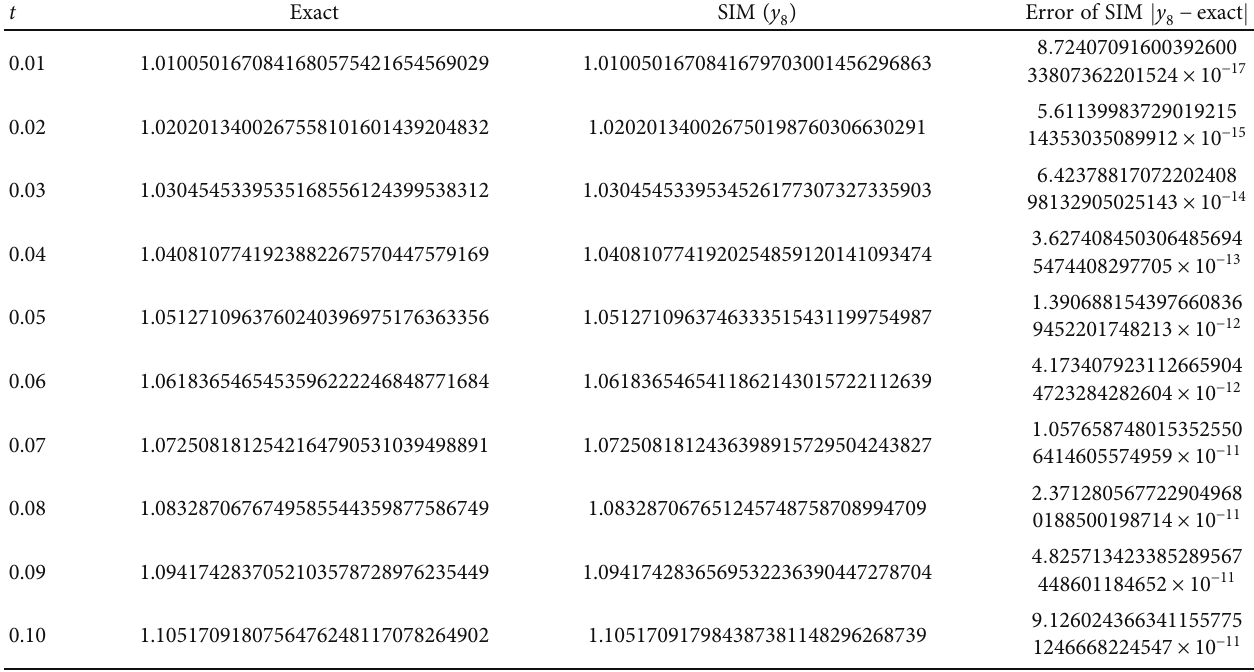
Table 5: Eight-term approximate solution by SIM and comparison with the exact solution of Example 3 for di ff erent values of time variable t and the absolute error E = j y 8 − exact j .